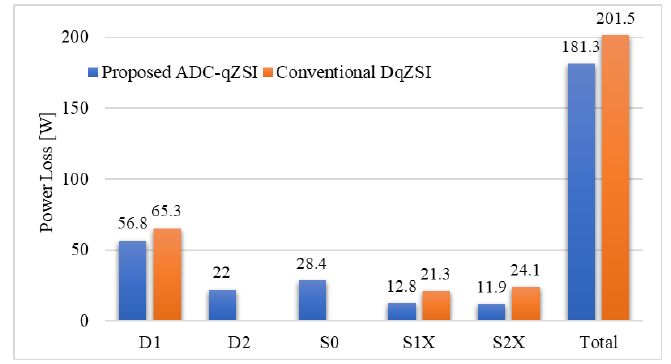
Figure 5. Comparison of semiconductor loss of proposed topology and conventional DqZSI in [8].